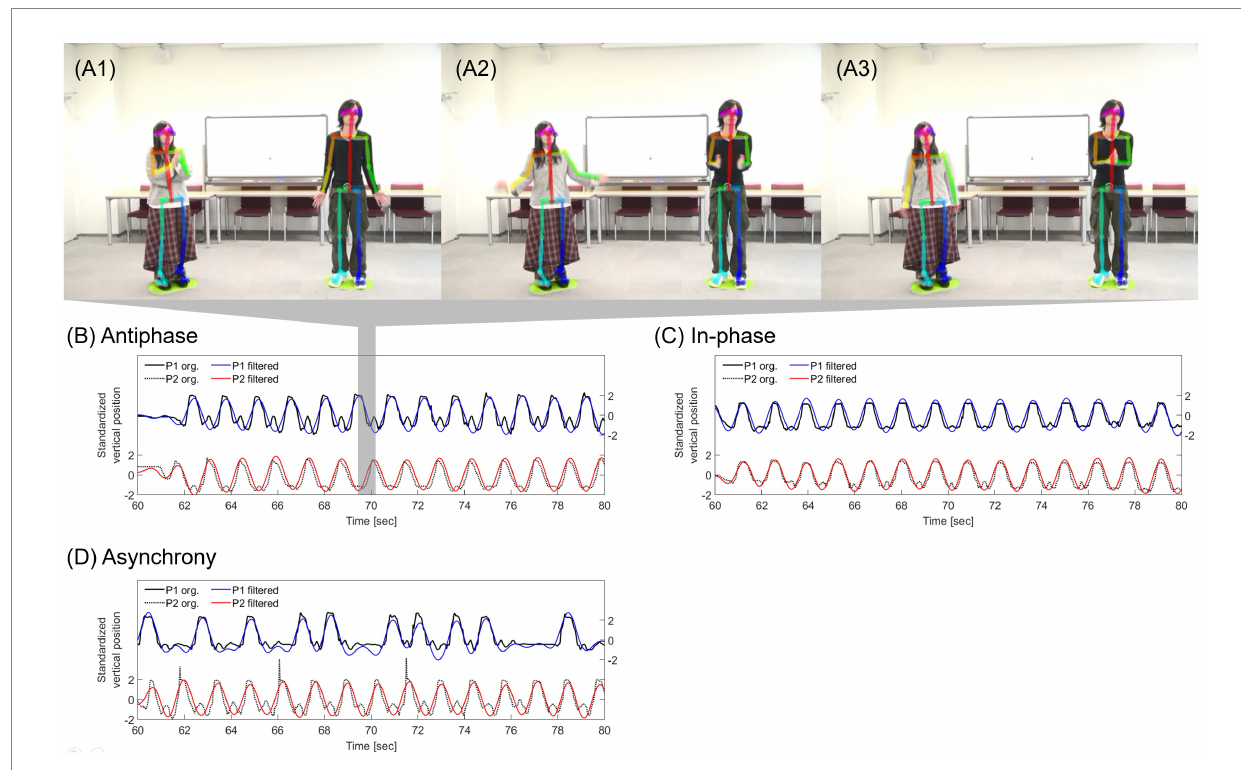
FIGURE 1 Experimental setting where participants stood on green rubber sheets. (A1–A3) represent the sequence in the pair for the antiphase condition. The stick figure overlaid on the participant was generated by OpenPose. (B–D) is an example of the two time series in the pair for the antiphase, in-phase, and asynchrony condition, respectively. Each band-pass filtered (0.25–2.00 Hz) time series was represented by red and blue lines on the raw